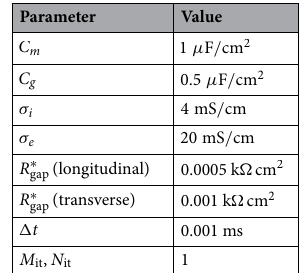
Table 3. Default parameter values used in the EMI model simulations, see, e.g., 30